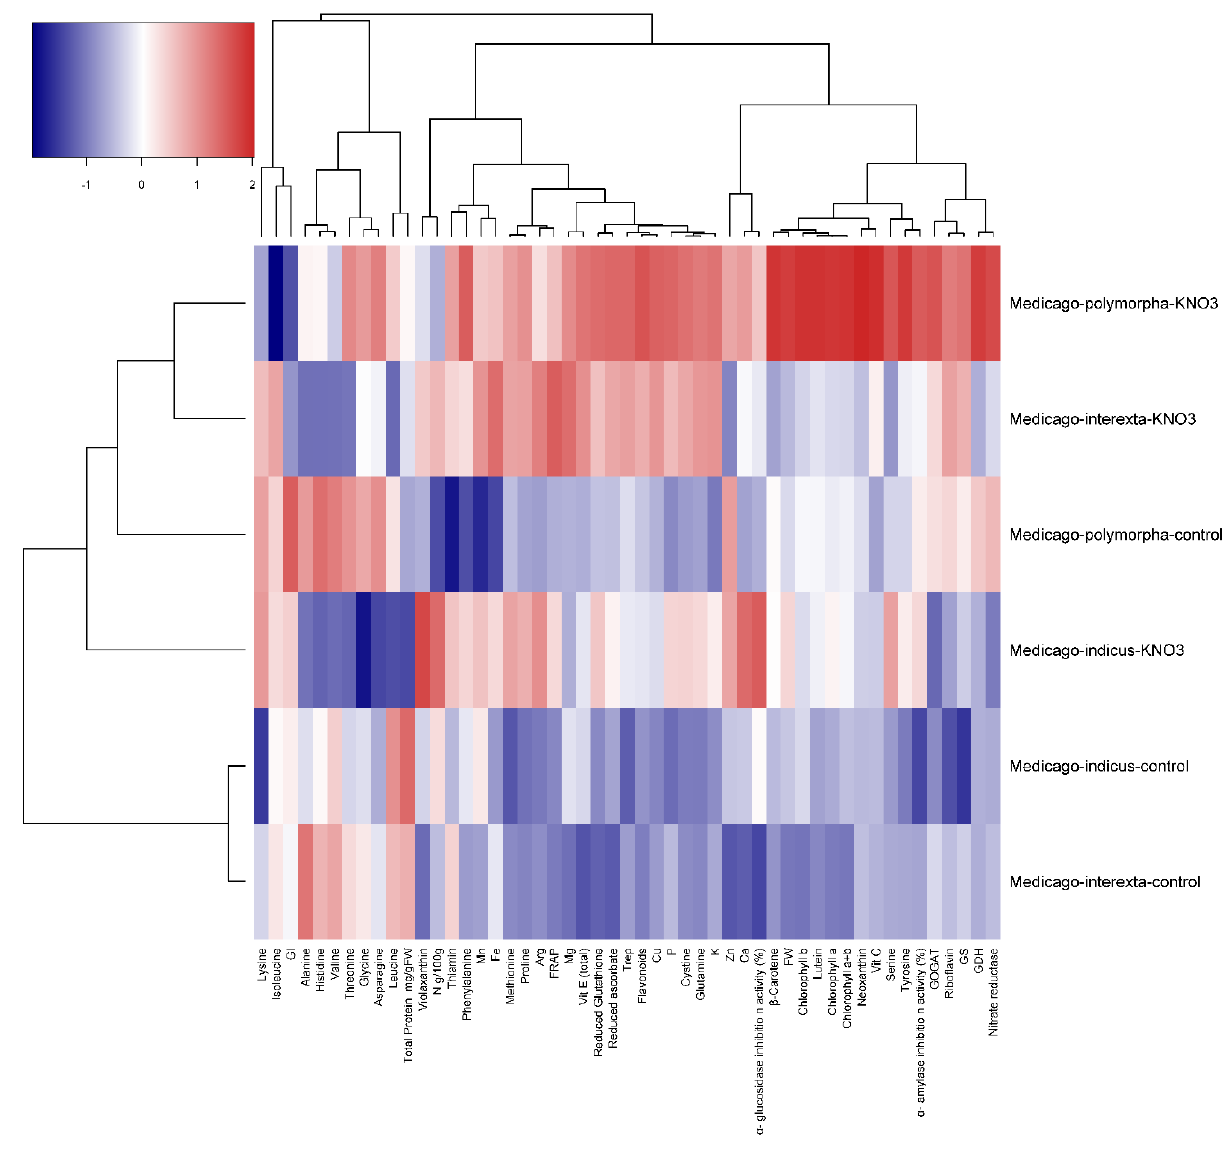
Figure 5. The cluster heatmap of primary and secondary metabolites of three Medicago species KNO 3 priming treatment. The graph’s horizontal axis shows different treatments for each species, and the vertical axis shows different phytocompounds, amino acids, and nitrogen content. Color gradients represent the different values of contents under KNO 3 priming compared with that of control.